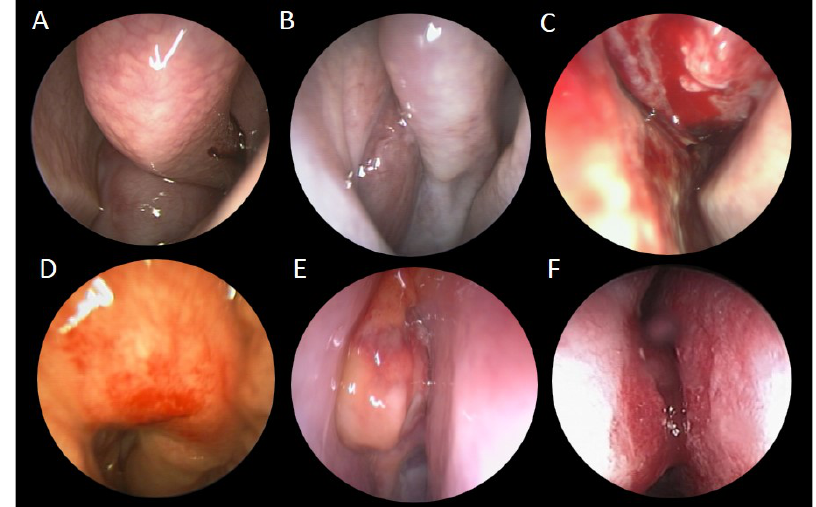
Figure 1. Endoscopic views of various sinonasal metastatic cancers. Endoscopic examinations